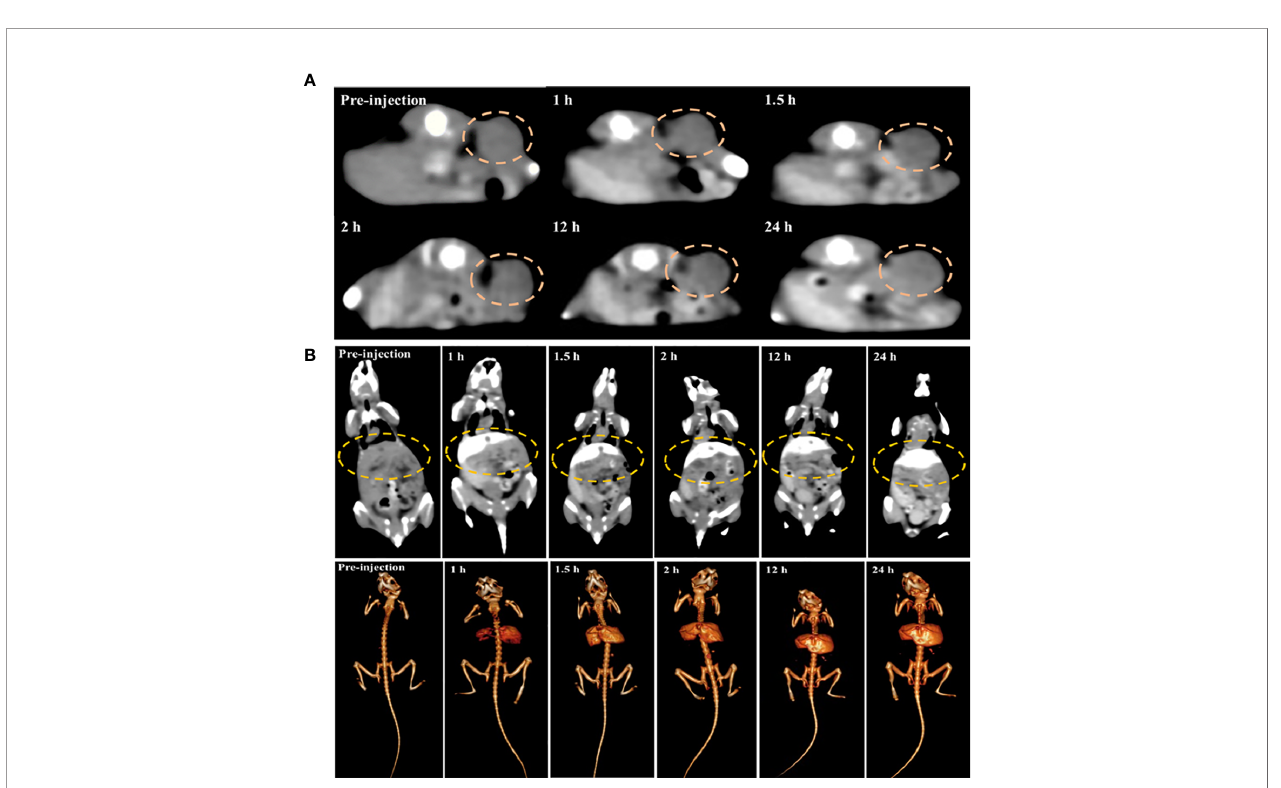
FIGURE 6 | (A, B) Changes of tumor site and mouse liver in different time point before versus post-injection of PEG-HoF 3